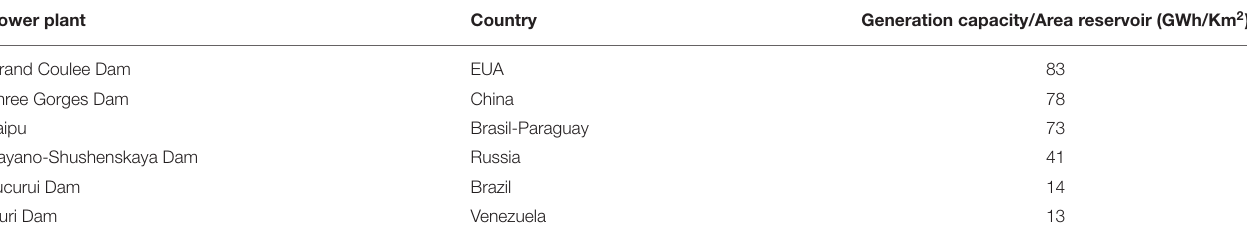
TABLE 2 | Production vs. flooded area–generation capacity relations produced by reservoir area in the world.